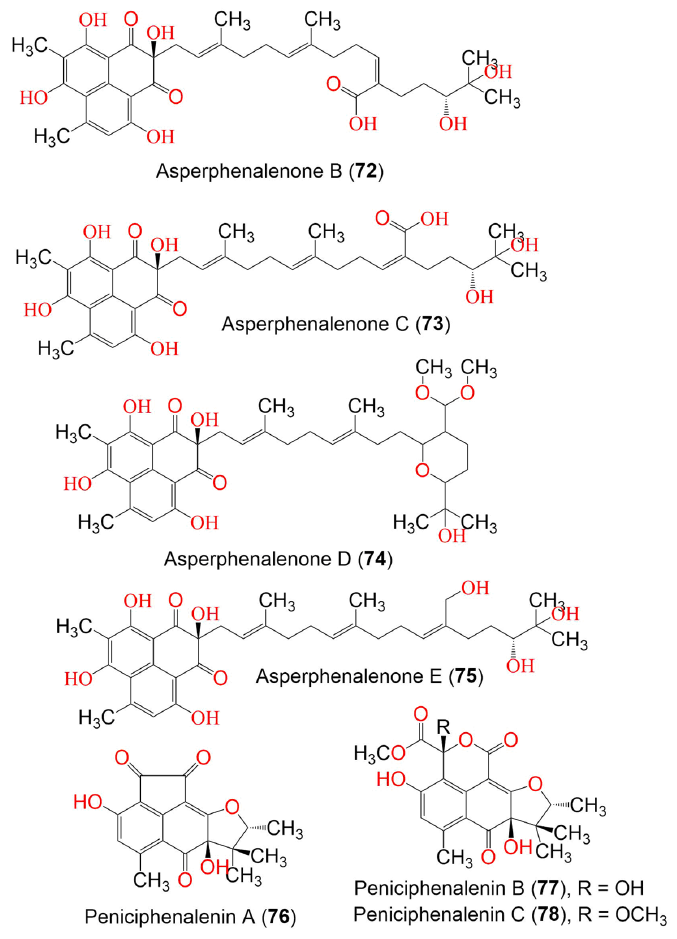
Figure 8. The structures of compounds 72 – 78 .